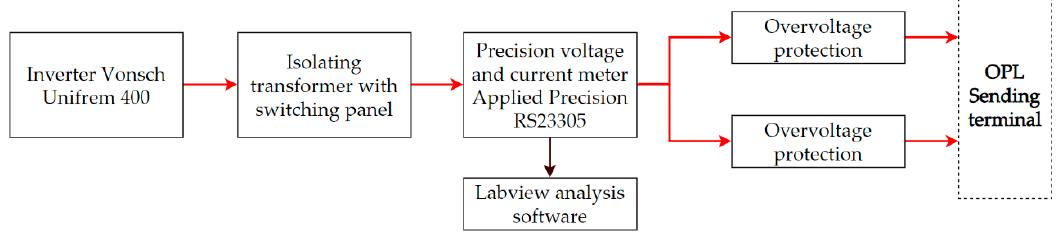
Figure 6. Block scheme of measuring apparatus.